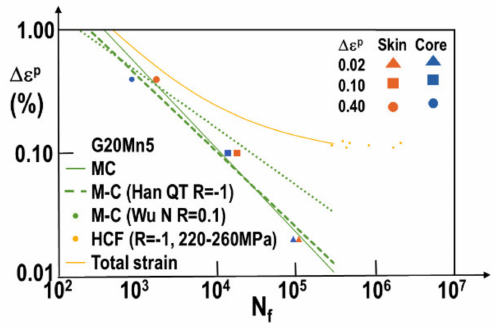
Figure 11. Manson–Coffin plot based on experimental values obtained in this work and compared to literature data. The latter are Han et al. work on quenched G20Mn5 and Wu et al. work on normalized G20Mn5. HCF data (yellow points) were obtained with applied stress tests. Corresponding elastic strain values are used to plot the results on this strain vs. number of cycles to rupture graph.